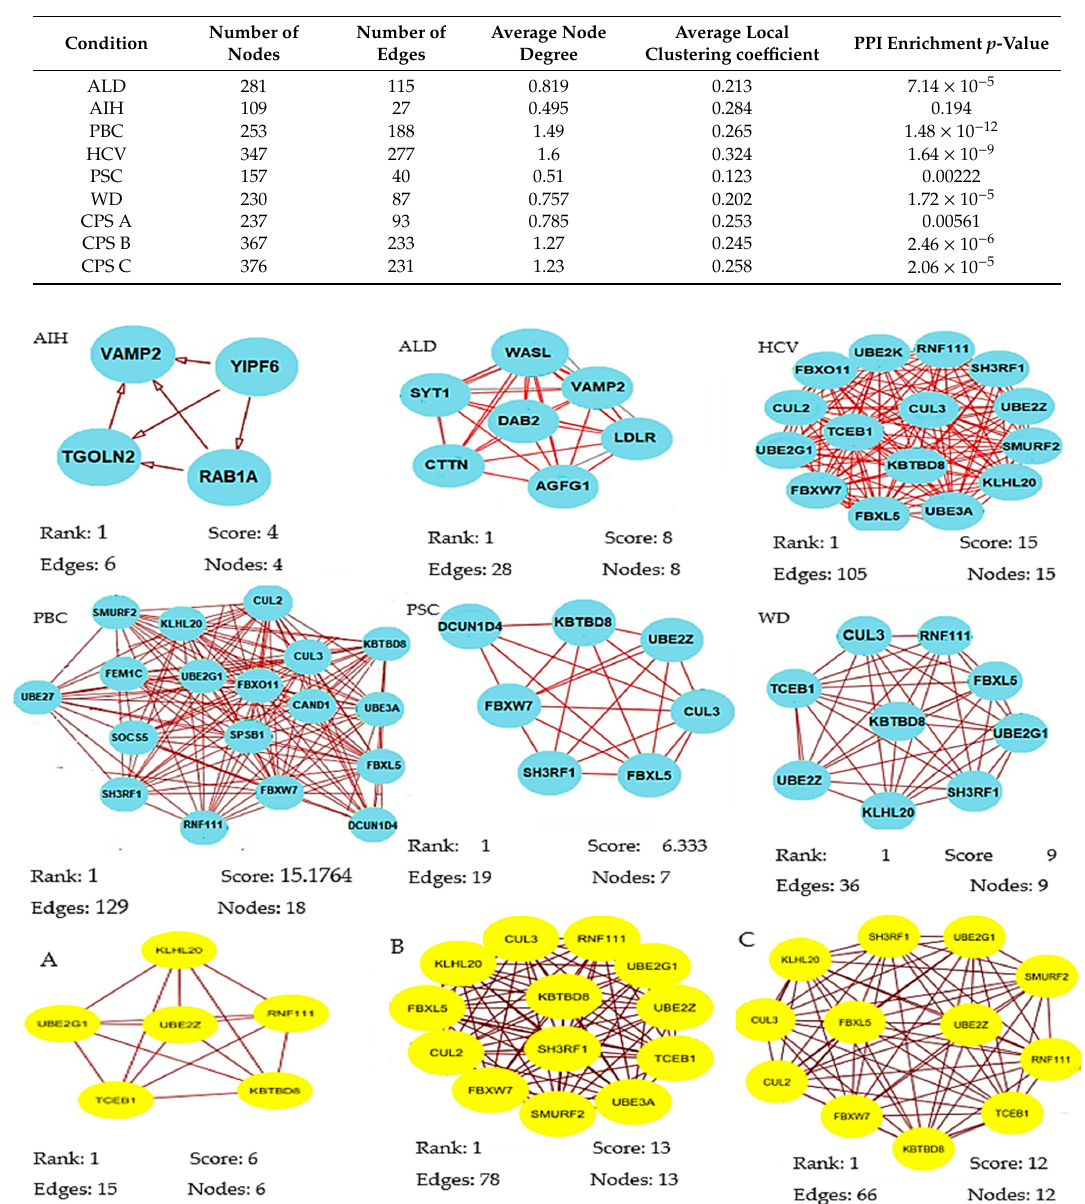
Table 2. The lists of some features of each study group’s protein–protein interaction (PPI) network.